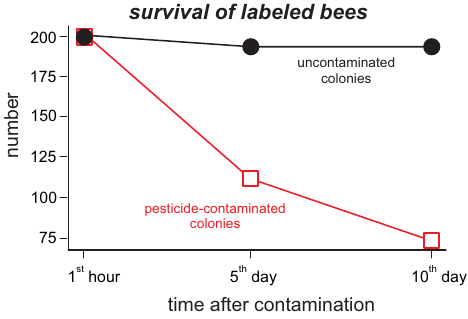
Figure 4. Temporal quantifications of labeled Apis mellifera individuals within observational hives. Each symbol represents the average value of four colonies. The measurements were conducted at the 1st hour, 5th and 10th day after the introduction of labeled bees within the